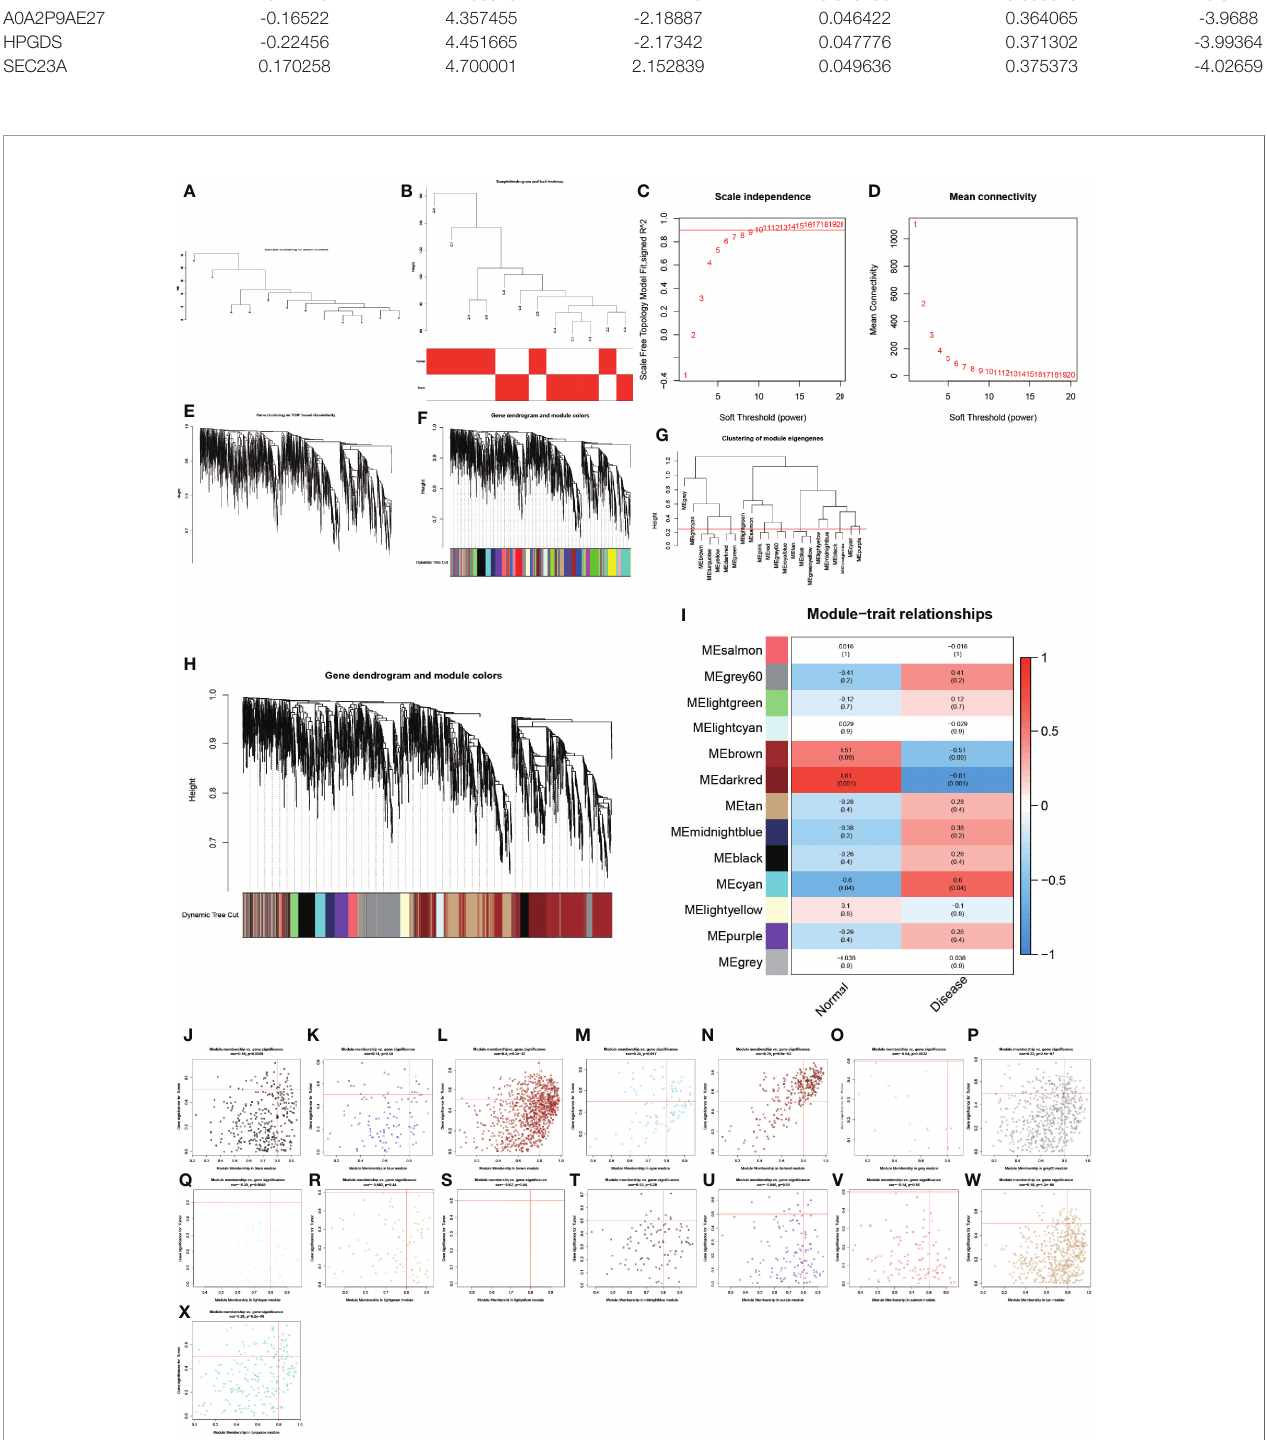
FIGURE 3 | Results of weighted gene co-expression network analysis. (A – X) show the entire WGCNA process, from sample clustering to correlation analysis, looking for the genes in the modules most associated with the